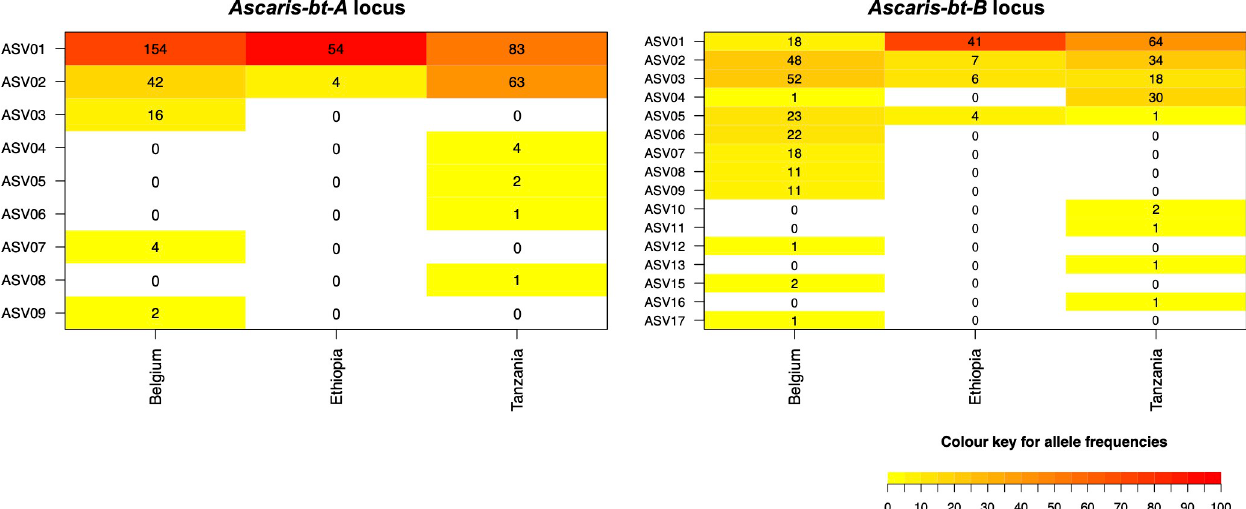
Fig 4. Allele counts for Alu/Asu-bt-A and Alu/Asu-bt-B in three adult Ascaris worm populations. Ascaris suum worms were collected from the intestines of pigs slaughtered in Belgium. Ascaris lumbricoides worms were collected during two expulsion studies in Ethiopia and Tanzania. The total number of each amplicon sequence variant (ASV) per population is displayed (allele count) and the color indicates the proportion within the population (allele frequency). Heatmaps were created using the R package PopGenReport [65,66].